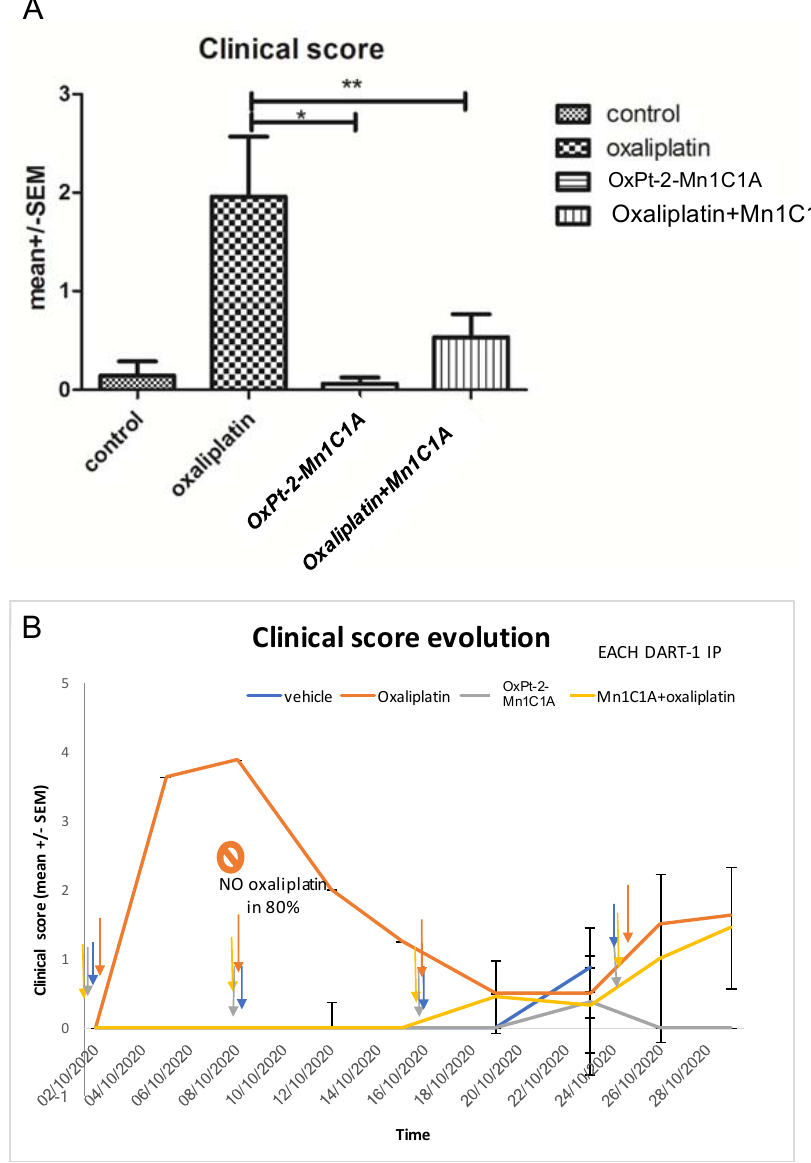
Figure 6. Clinical score in BALB/c mice inoculated with CT26 and treated by weekly intraperitoneal injection with vehicle (8 mice), oxaliplatin (8 mice, 10 mg/kg/week), OxPt-2-Mn1C1A (9 mice, 10 mg/kg/week), and Mn1C1A + oxaliplatin (9 mice, 10 mg/kg/week). The clinical score, proportional to toxicity, was evaluated blindly in each mouse, by the investigator with four criteria: asthenia, alopecia, diarrhea, and weight loss. ( A ) Mean clinical score in each group depending on the treatment received. The p -values are denoted as follows: * p < 0.05 and ** p < 0.01. ( B ) Clinical score evolution over time. Each dart represents 1 intraperitoneal injection of each treatment. In the oxaliplatin group, 80% of the mice did not receive the second oxaliplatin IP injection due to weight loss of >20%. In the Mn1C1A + oxaliplatin and OxPt-2-Mn1C1A group, the clinical score raised with tumor growth over time but no significant toxicity was observed, and every IP injection could be